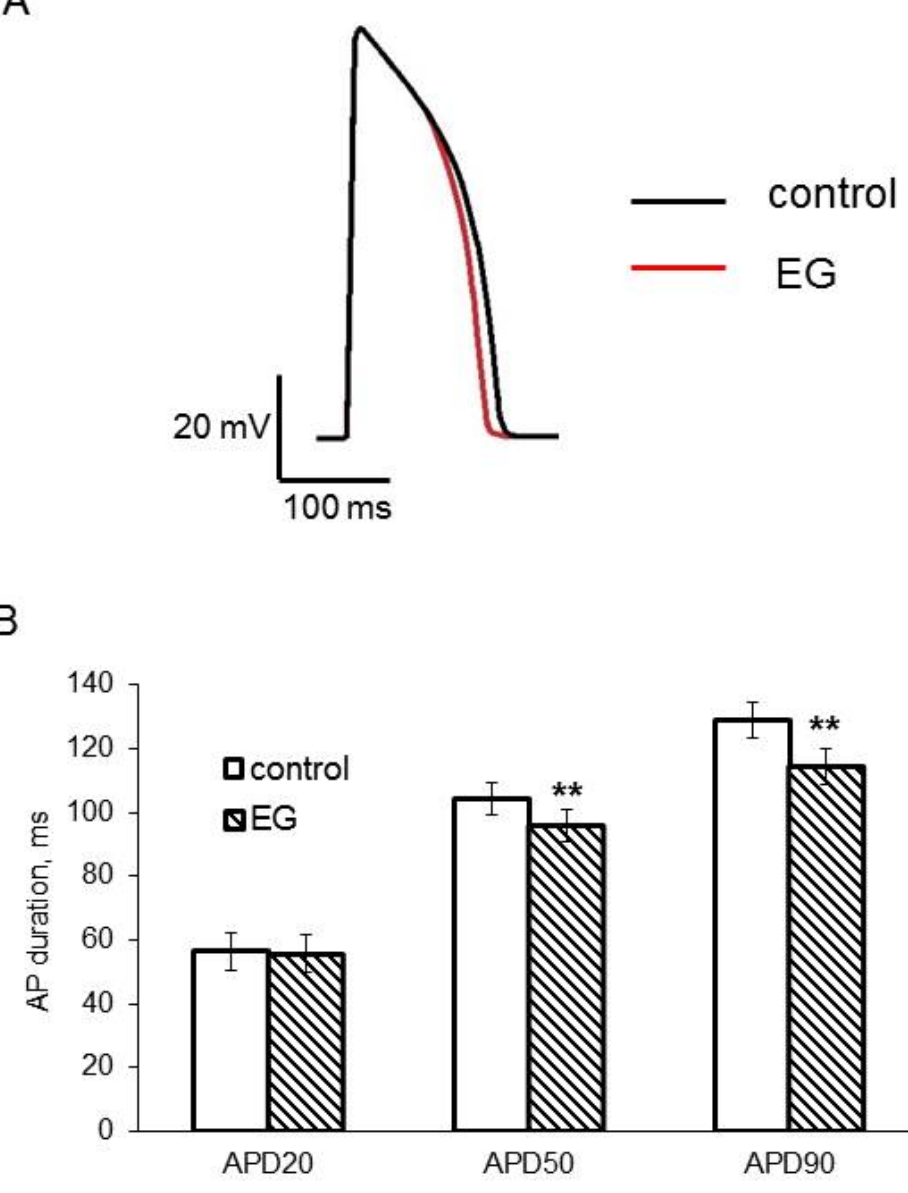
Figure 7. ( A ) Representative recording of ventricular AP from ex vivo zebrafish heart. Black line shows AP in control and red in 5 µ M empagliflozin–treated heart. ( B ) Bar graphs of mean results for APD20, APD50, and APD90 in control ( n = 5) and empagliflozin–treated ( n = 5) heart. ** p < 0.01 obtained by paired Student’s t –test.